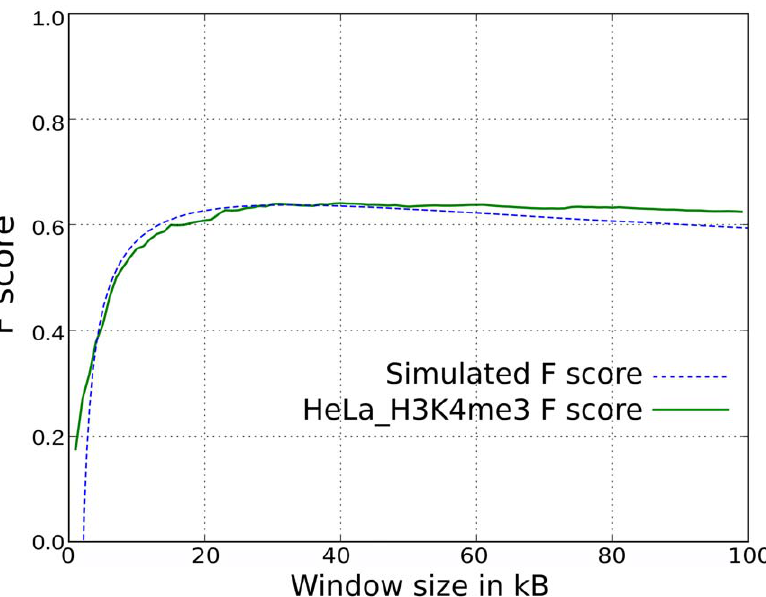
Figure 5. Association (F score) between HIV-1 proviruses and two markers as a function of window size in kB. The first marker is H3K4me3 sites in HeLa (green solid line). The second is a virtual marker placed in the promoter region of transcribed genes in HeLa cells (blue dashed line), assuming a uniform distribution of integration sites in transcribed regions. The median length of transcribed genes in HeLa is , 20kB.